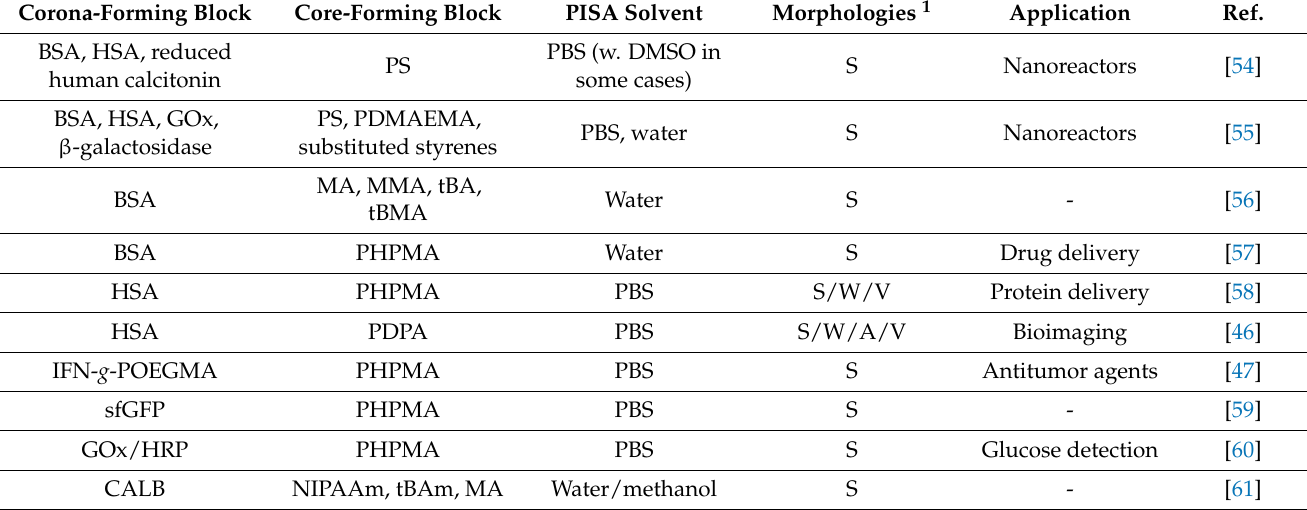
Table 1. Summary of corona- and core-forming blocks, reaction solvents, obtained morphologies, and applications of protein–polymer hybrid nanostructures prepared via